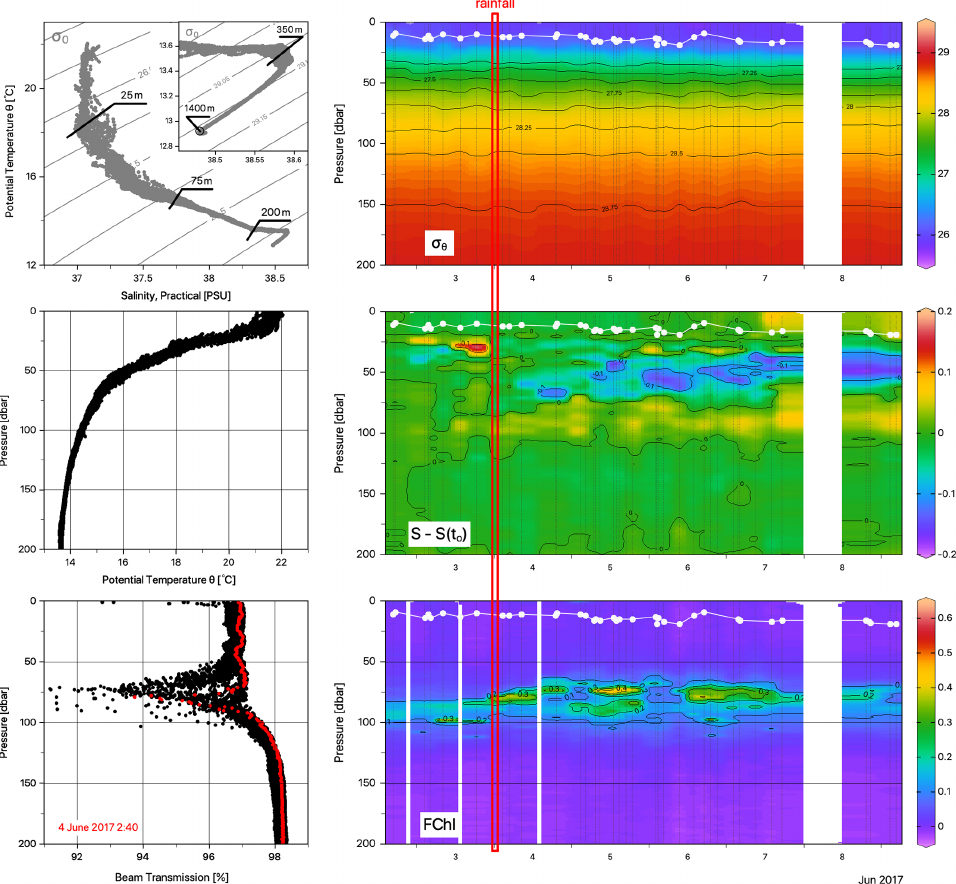
Figure 13. Left panels: temperature–salinity diagram (upper panel), temperature profiles (middle panels) and profiles of beam transmission (lower panel). Right panels: evolution of the surface stratification (sq, upper panel), salinity (anomalies to the profile of 2 June, 16:30, middle panel) and chlorophyll fluorescence (lower panel) at the FAST station. Time series are composed of 43 repeated CTD casts, with variable temporal resolution. The depth of the mixed layer is indicated by white dots. The time of the rainfall is indicated by the red